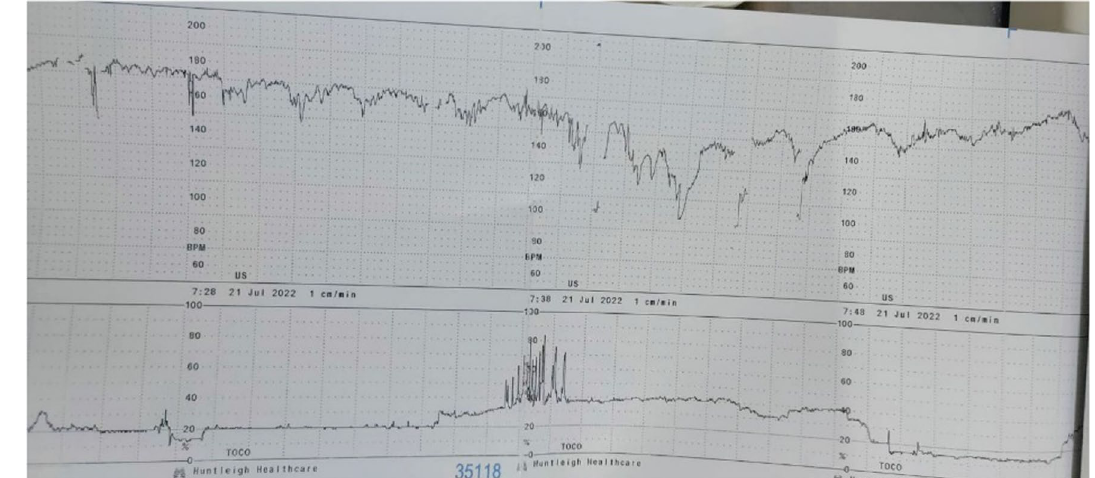
Fig. 1 Abnormal CTG with fetal tachycardia and unprovoked fetal decelerations